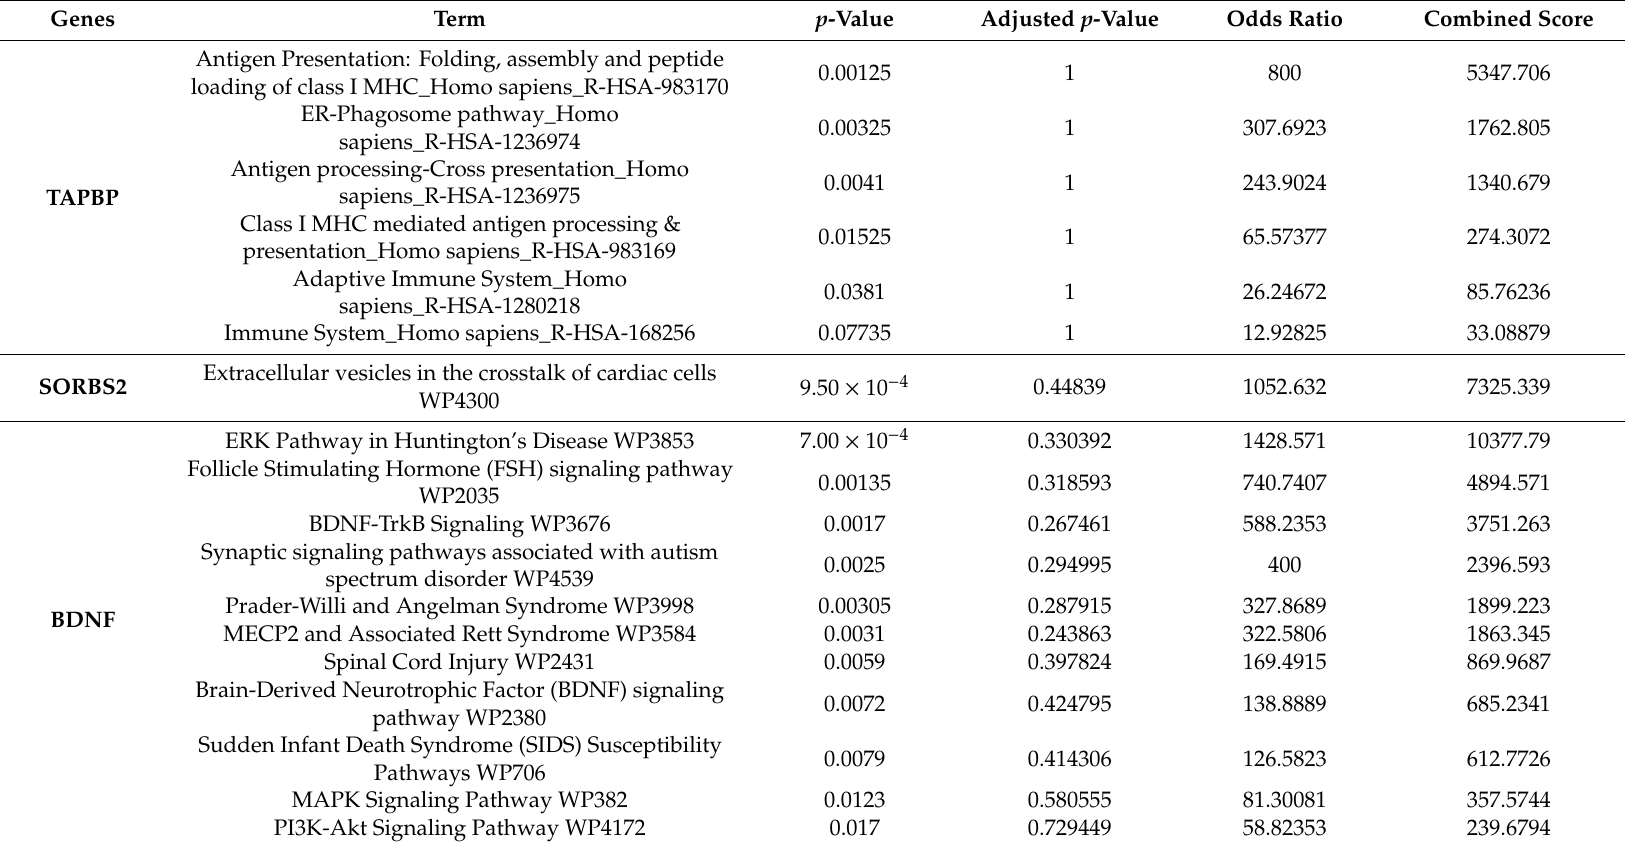
Table 3. Pathway analysis interaction for overlap genes in obesity and mood